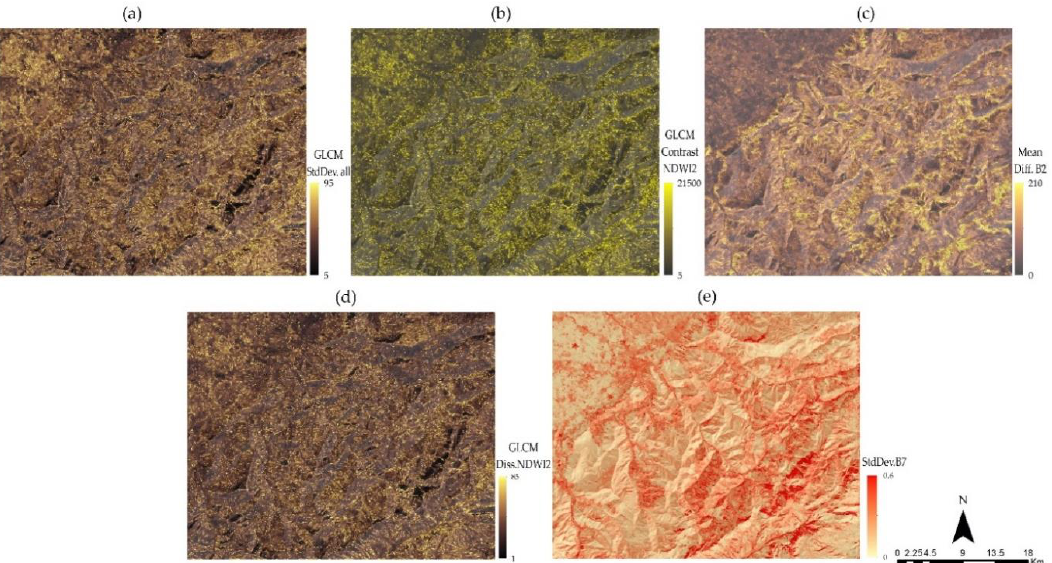
Figure 8. The spatial variations of the top five important variables in mapping of historical landslides in the non-protected forests, NE Iran; the standard deviation derived from the GLCM of all channels of Sentinel-1 and -2A ( a ), the contrast derived from the GLCM of NDWI2 ( b ), the mean difference to neighbors of the blue band (B2; Sentinel-2A) ( c ), the dissimilarity derived from the GLCM of NDWI2 ( d ), and the standard deviation values of the red-edge 3 band (B7; Sentinel-2A) ( e ). The vegetation indices are useful for discriminating landslide-induced barren lands, debris flows, and failure slopes from surrounding undisturbed-forest areas [10,16,18,20]. The improvement NDVI derived from ETM + [14,15], SPOT-5 [17], and GF-1 [10]; GNDVI derived from SPOT-5 [17] and